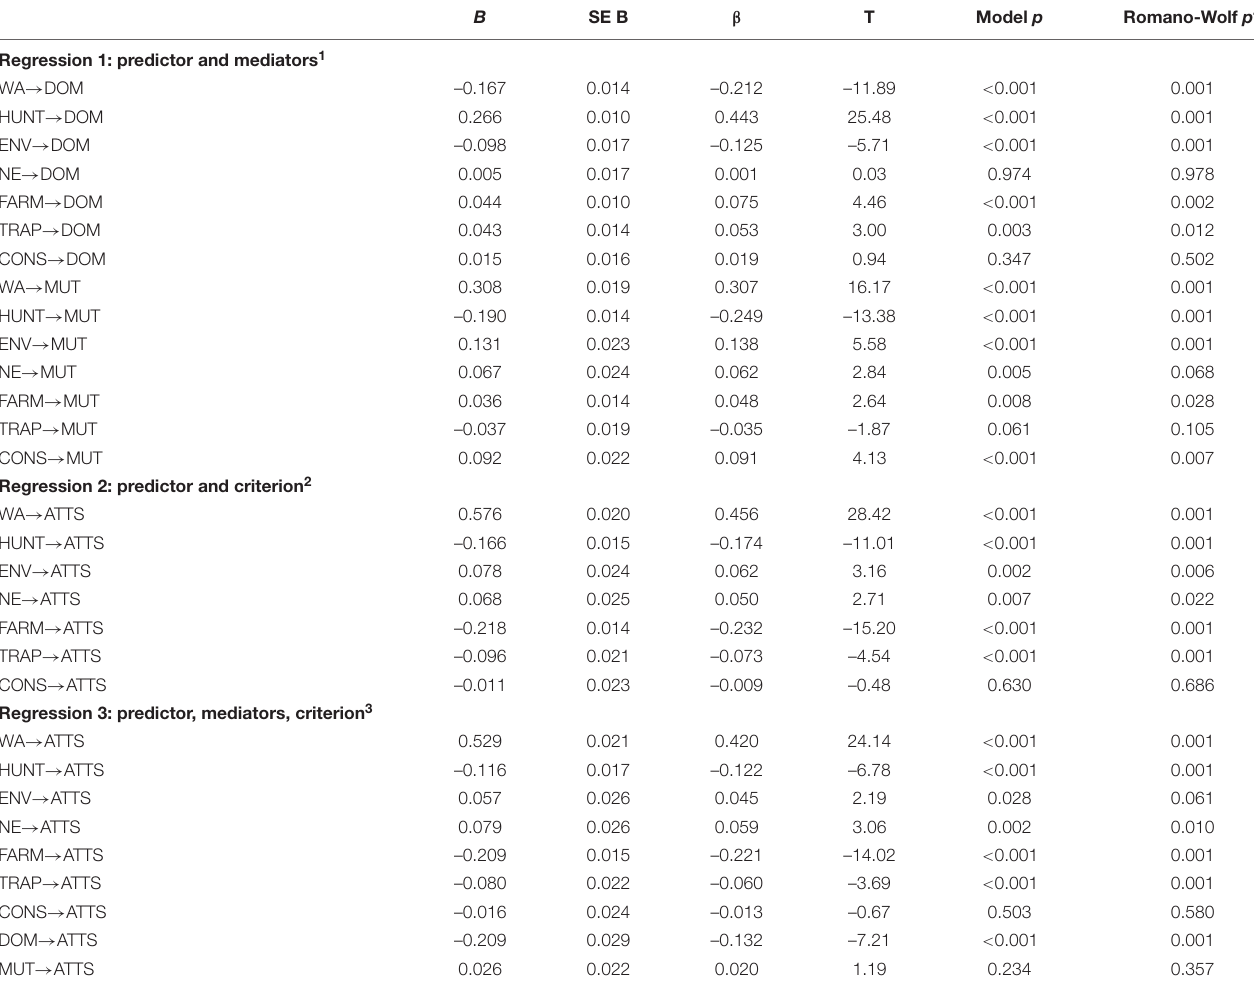
TABLE 5 | Summary of regression mediation analyses examining of how identities and wildlife value orientations predict attitudes about wolves for wolf stakeholders in Minnesota, United States. B SE B β T Model